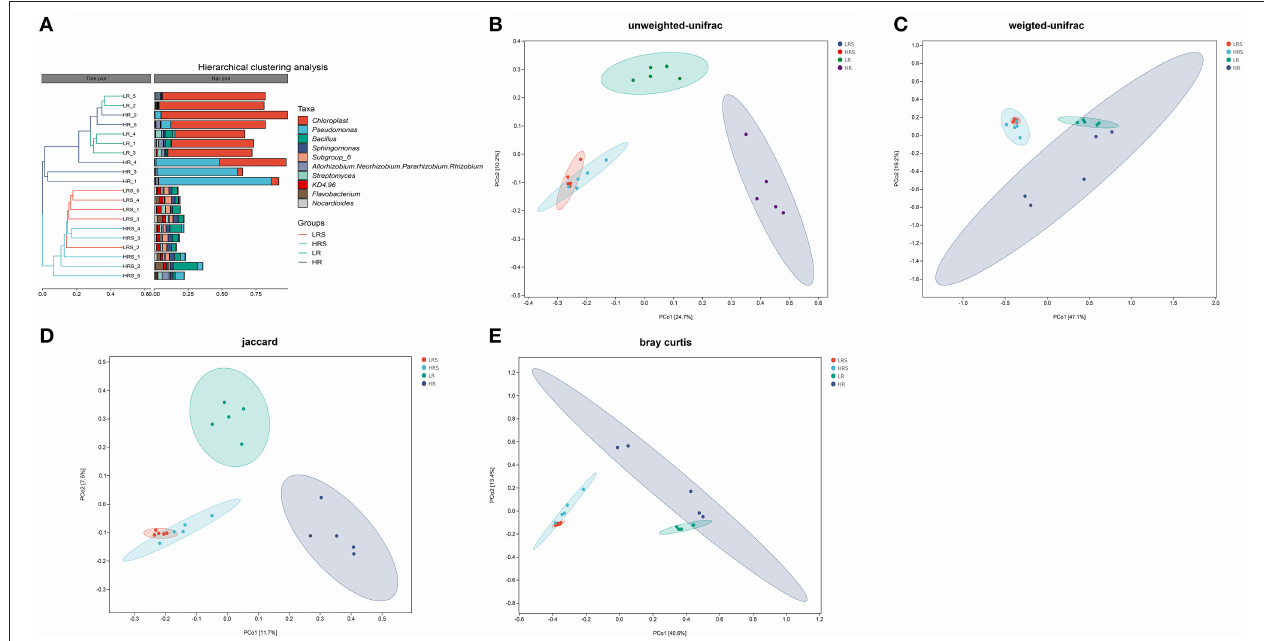
FIGURE 4 | The difference in the bacterial community structure between the LR and HR soil–root system. (A) The hierarchical clustering analysis of the LR and HR soil and roots is based on the class level. (B–E) Principal coordinate analysis (PCoA) is based on the unweighted UniFrac algorithm (B) , weighted UniFrac algorithm (C) , Jaccard algorithm (D) , and Bray–Curtis algorithm (E)